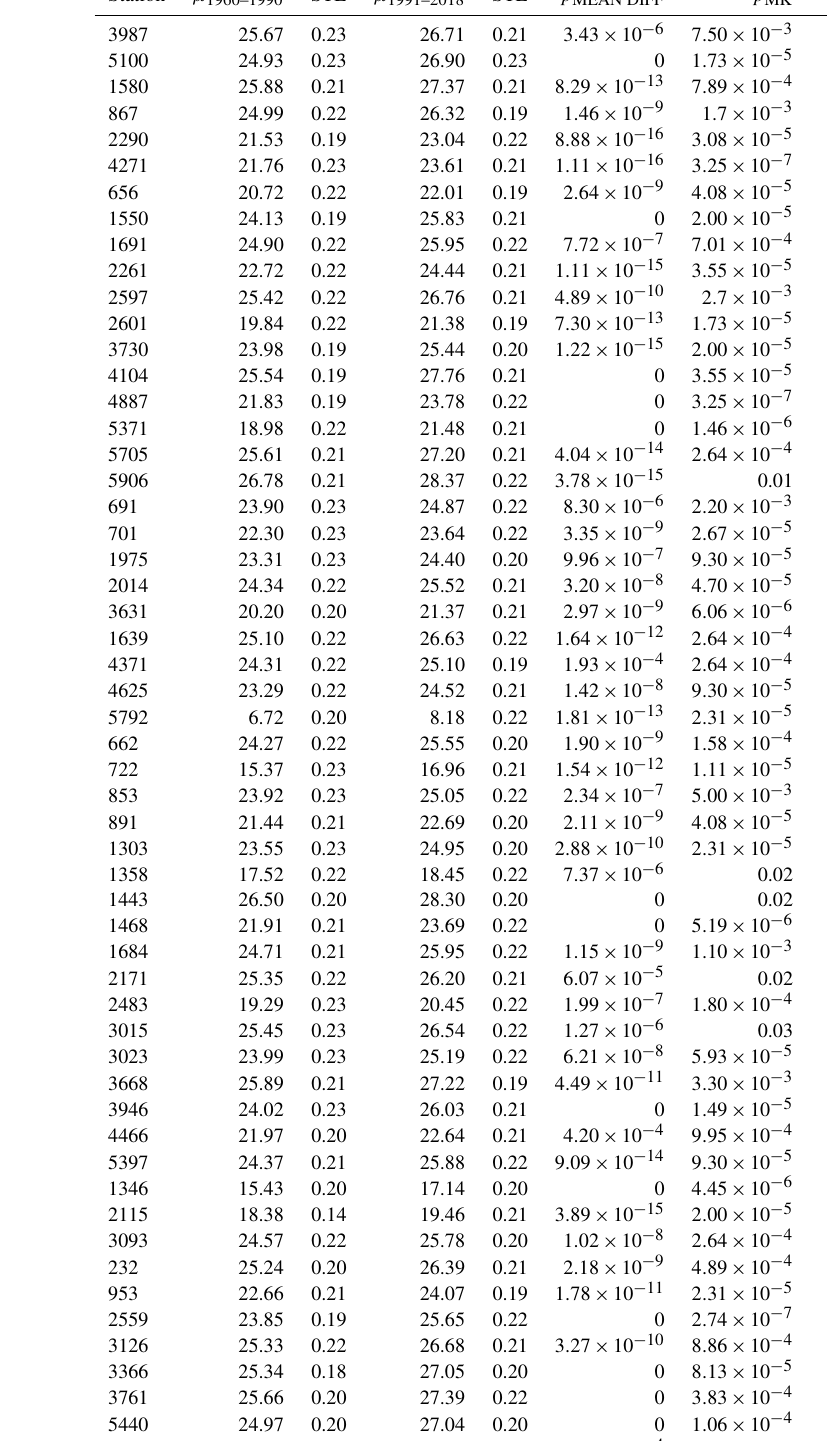
Table A2. Location trend results for the hourly temperature time series. p MEAN DIFF H A : µ 1960–1990 < µ 1991–2018 and p MK H A :